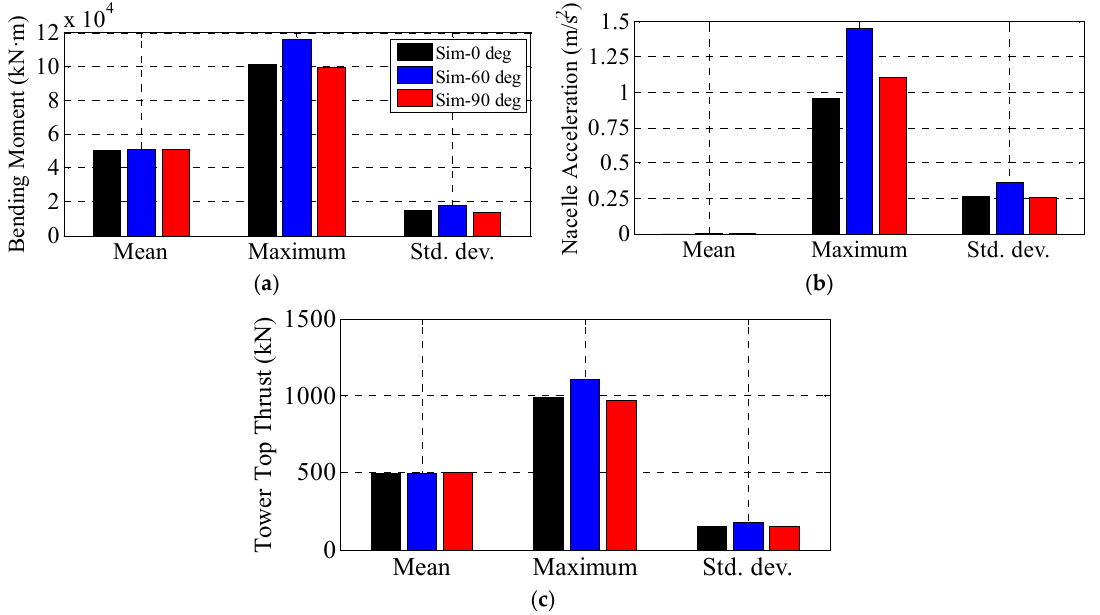
Figure 29. Statistical data of fore-aft ( a ) tower base bending moment; ( b ) nacelle acceleration and ( c ) wind thrust.